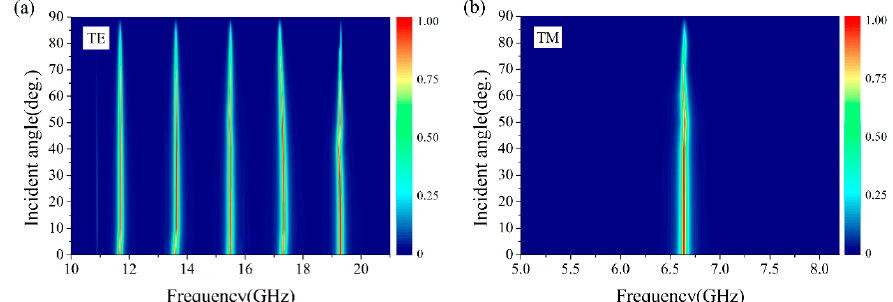
Figure 5. The absorptivity for ( a ) TE polarization mode and ( b ) TM polarization mode with different incident angle θ .